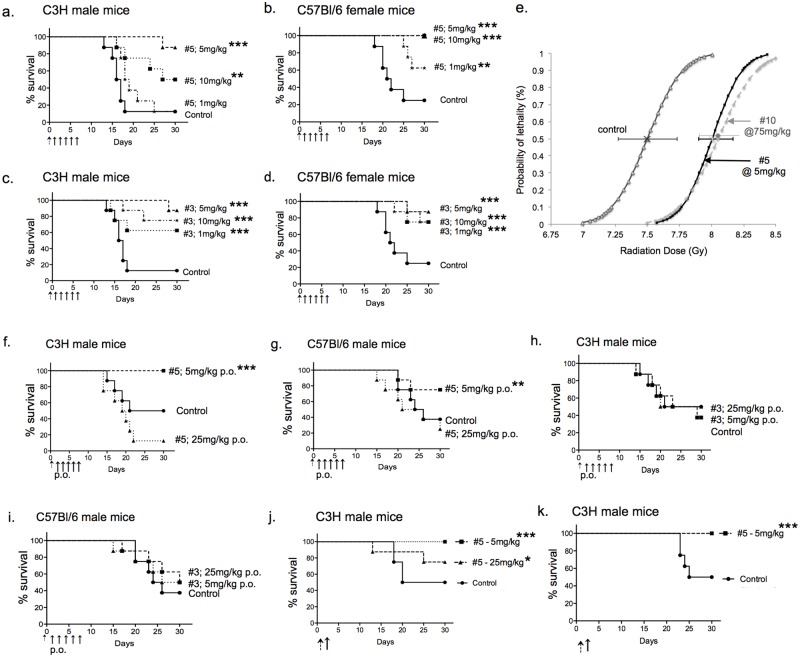
Efficacy of compounds in different conditions.Compounds #5 (a, b) and #3 (c, d) in C3H male (a, c) and C57Bl/6 female (b, d) mice with 5mg/kg given s.c. on day 1 and daily for 5 days. This dose is generally superior to 10 and 1mg/kg (this figure), and 75 and 25mg/kg (Fig 1) for mitigating hARS after WBI (LD70/30 estimated doses used for the different strains). (e) Male C3H mice treated s.c. for 5dys with 5mg/kg compound #5 or 75mg/kg compound #10 have increased resistance to hARS. LD50/30 control = 7.5Gy (95% c.l. = 7.34–7.67); # 5 LD50/30 = 8.0Gy (95% c.l. = 7.9–8.2); #10 LD50/30 = 8.2Gy (95% c.l. = 8.07–8.58). Compound #5 given by gavage at 5mg/kg for 5dys mitigates hARS (LD70/30) in C3H (f) and C57Bl/6 (g) male mice whereas compound #3 does not (h, i). A single s.c. injection of 5mg/kg of compound #5given 24hrs after WBI (LD70/30) mitigates against hARS in C3H mice (j). (k) Compound #5 given 18hrs before WBI (LD70/30 estimated dose of 7.725Gy) as a single 5mg/kg s.c. injection radioprotects C3H male mice from hARS. (*p<0.05, **p<0.01, ***p<0.001).